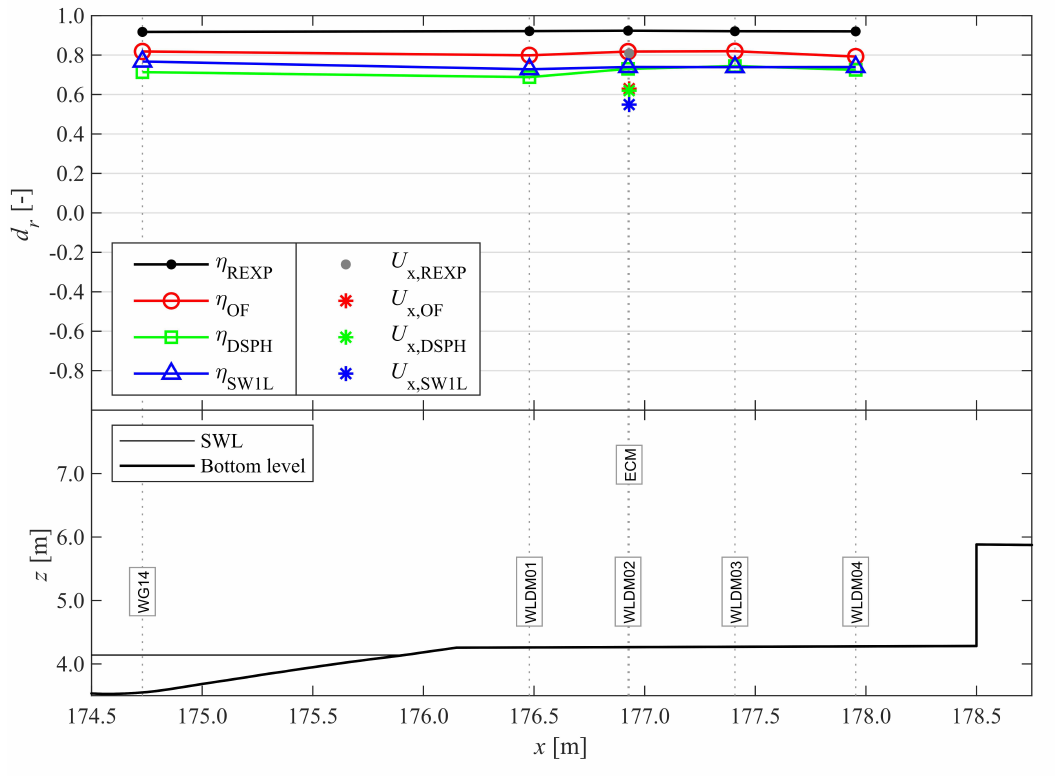
Figure 12. Comparison of d r , evaluated for η and U x (of REXP, OF, DSPH and SW1L with reference to EXP) from the toe of the dike up to the vertical wall. From top to bottom: d r for η and U x , and finally an overview of the sensor locations, SWL, and bottom profile. Adapted from the work in [3], with permission from the authors,